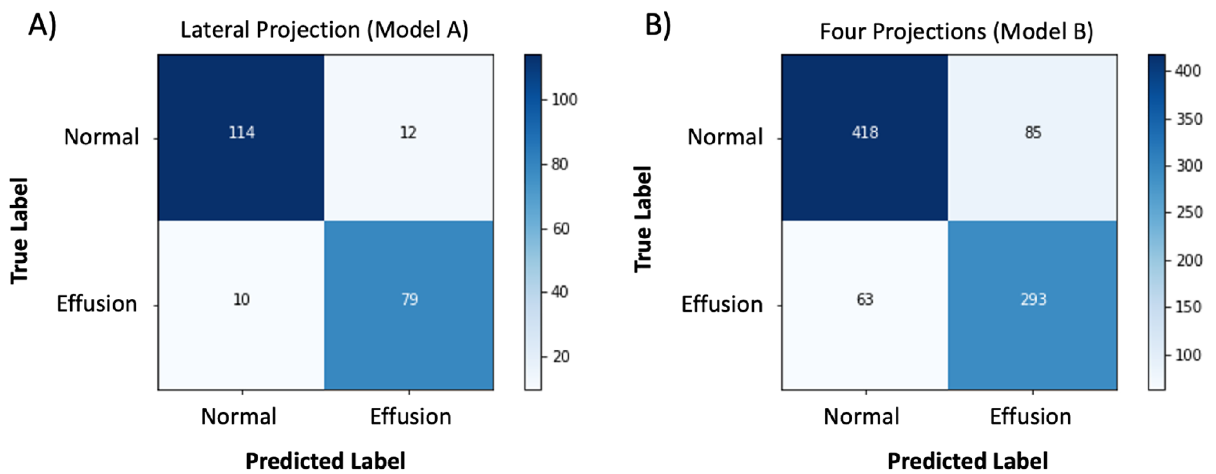
Figure 7. Averaged confusion matrices for the model A and B over the 10 iterations. Confusion matrices show performance of a deep learning model that was trained with only lateral projection ( A ) and a model that was trained with four projections ( B ).